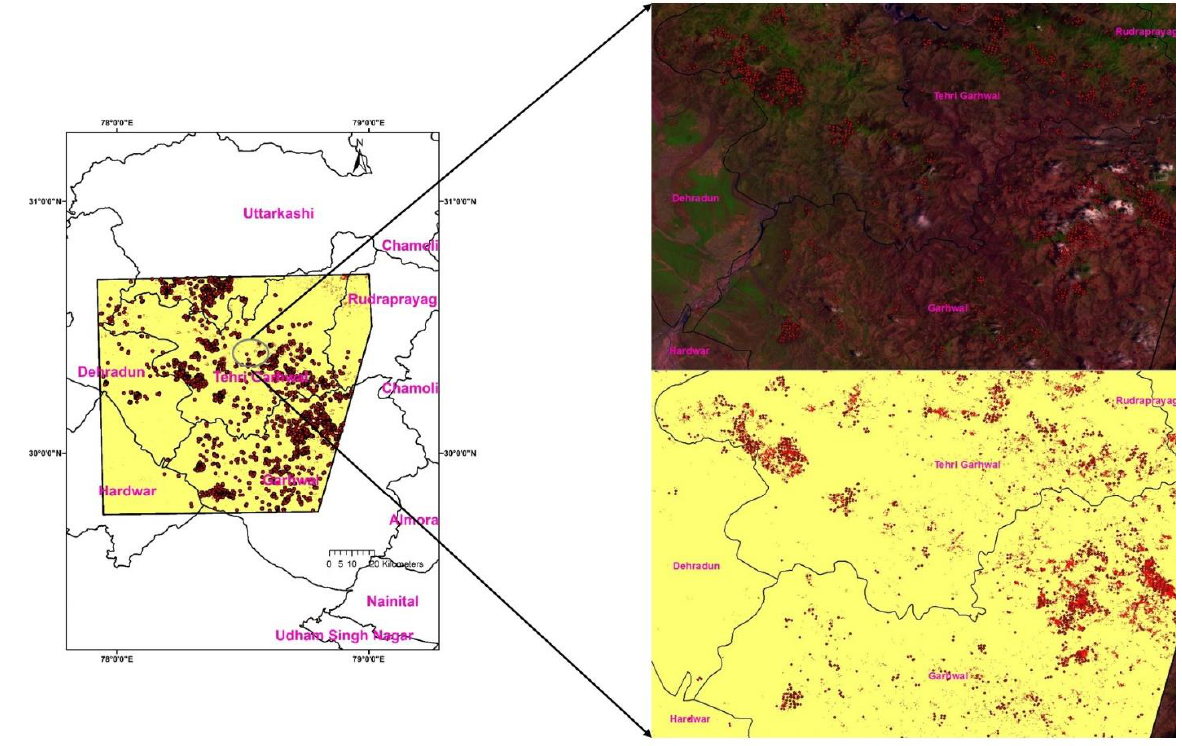
Figure 5. Relativized Burn Ratio map and zoomed extent shows the active fire hotspots overlaid